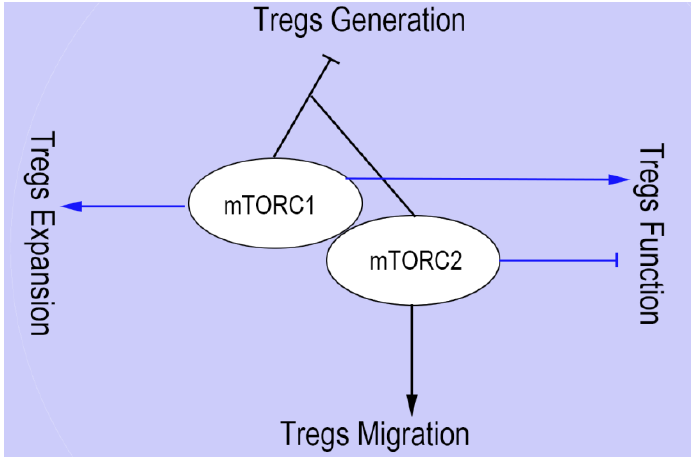
Figure 2. The roles of mTORC1 and mTORC2 on Tregs generation, expansion, function, and migration. The absence of mTOR signaling dramatically increase Tregs generation, while deleting either mTORC1 or mTORC2 signaling does not lead to the upregulation of Foxp3+ Tregs. mTORC1 and mTORC2 play opposite roles in Tregs function, the absence of main component Raptor of mTORC1 limits Tregs function, and lack of mTORC2 increases Tregs function via promoting the activity of mTORC1. mTORC2 promotes the migration of Tregs to inflammatory sites. However, the effects of mTORC1 on the Tregs migration remain unclear. mTOR signaling is essential for Tregs expansion. Consequently, Slc3a2-deficient Tregs have an impaired mTORC1 pathway and show lower proliferation ability. However, the role of mTORC2 on Tregs expansion remains unclear.